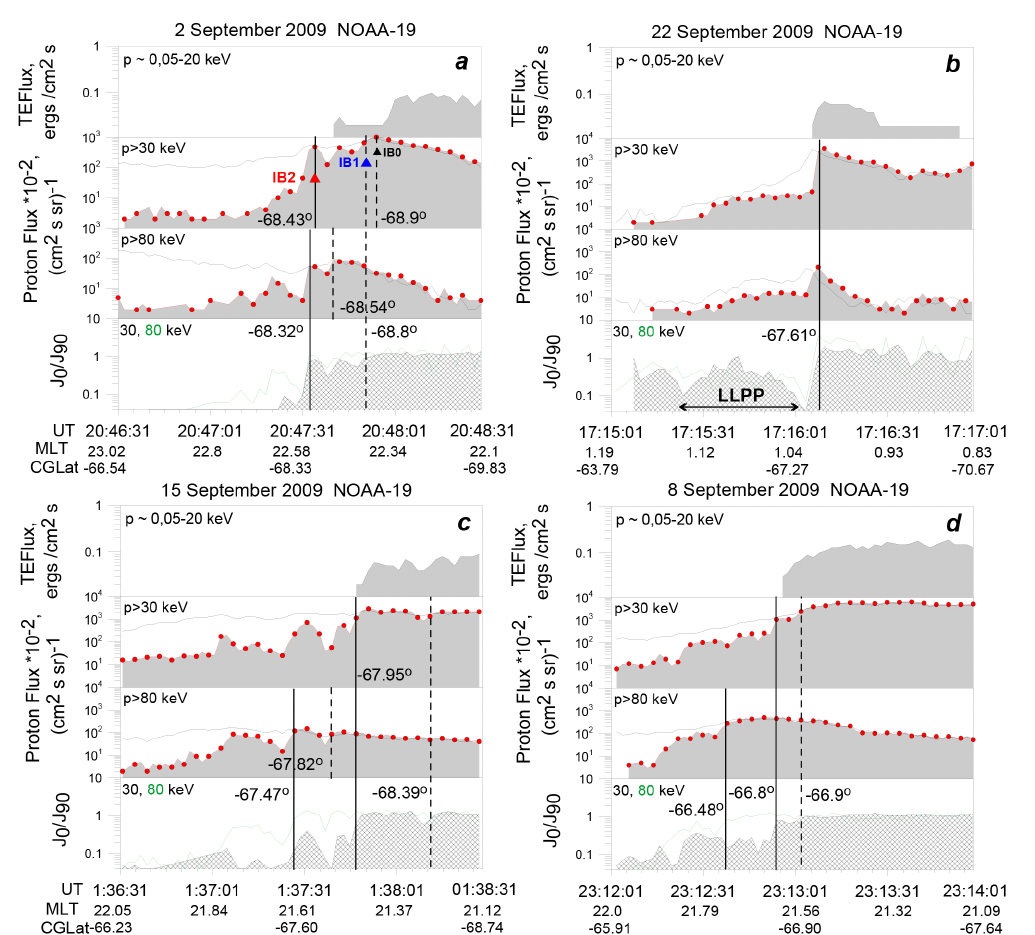
Figure 5. Examples of more complicated behavior including structured IB (with no IB dispersion) (a) , no IB dispersion case with adjacent but separated LLPP (b) , well-defined structured IB at the LLPP background (c) , and “gradually developing IB” that interfered with LLPP background (d) . The structured IBs have been characterized by the peak precipitated flux (IB0), poleward-most J 0 /J 90 dropout (IB1) and equatorward-most J 0 /J 90 dropout (IB2), used also as the IB proxy in the statistical